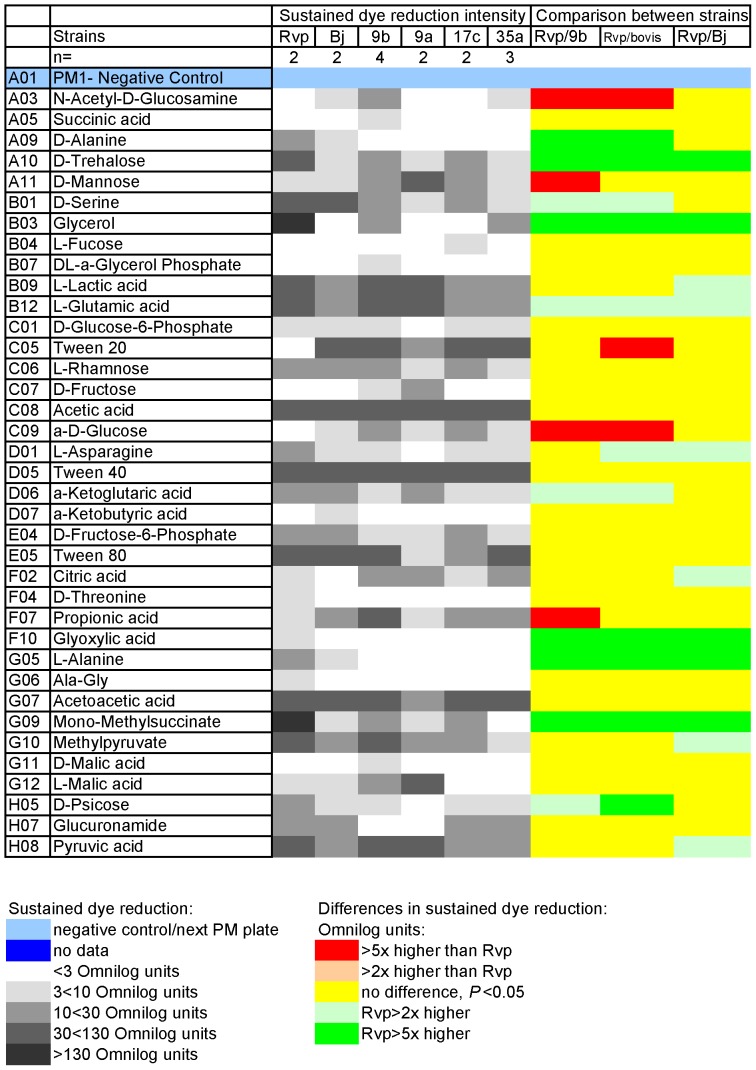
Major carbon sources (Plate PM1) giving sustained dye reduction, from 48 h reading to end (165 h).n = Number of incubations (from separate pre-cultures). Code (corresponds with Table 1): Rvp = H37Rv (AHVLA); Bj = Bj 5208; 9a = type 9 61/0038/01; 9b = type 9 AF2122/97; 17c = type 17 21/7917/05; 35a = type 35 61/1307/01. Cut off for +ve is 3, the median value for well PM01, A03, since we confirmed substrate use as a C-source by growing in culture flasks using it.